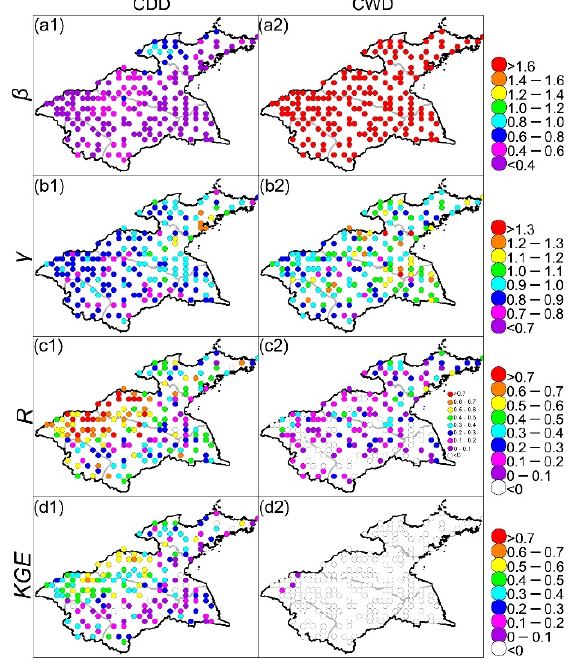
Figure 6. Spatial patterns of different validation metrics for the duration-based indices.